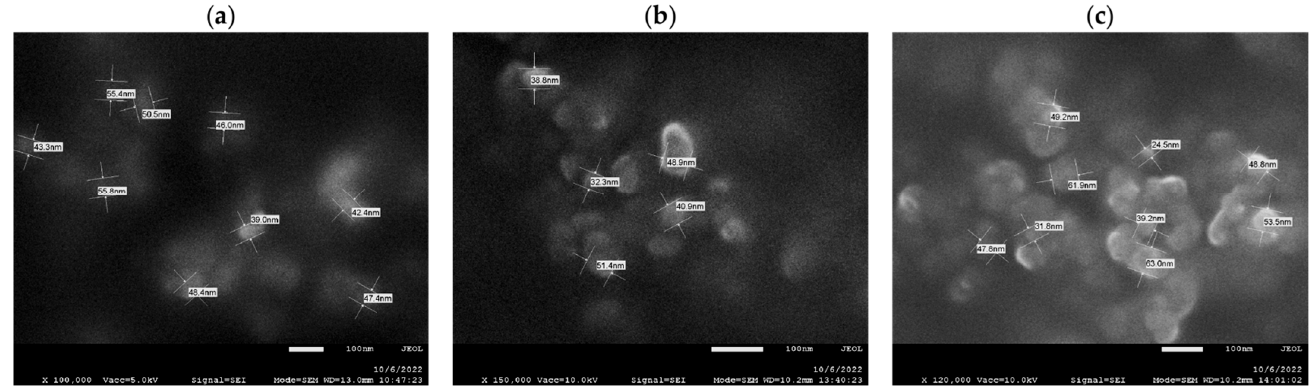
Figure 5. Scanning electron microscope images (C—( a )) nanocellulose obtained by enzymatic hy- drolysis and nanocelluloses functionalized with ionic liquids with shorter (C-IL1—( b )) and longer (C-IL2—( c )) alkyl linkers.